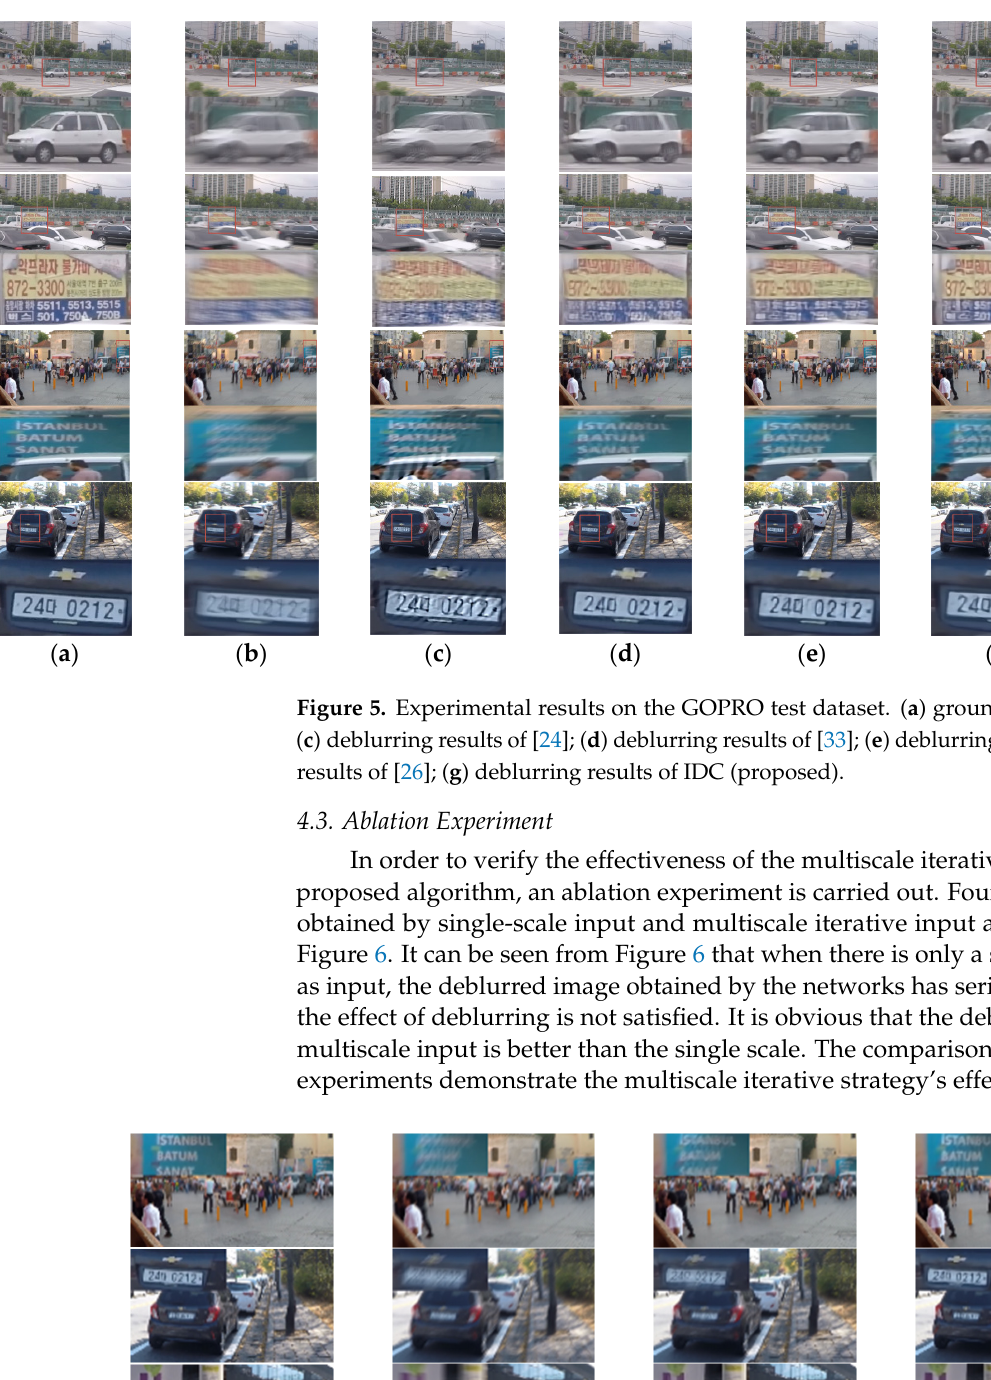
( d ) Figure 7. Ablation Experiment of Texture Sub-Network. ( a ) ground truths; ( b ) blurred images; ( c ) deblurring results of IDC without Sub-Texture; ( d ) deblurring results of IDC (proposed). 5. Conclusions This paper presents an iterative dual-CNN procedure for image deblurring. The net- work consists of deblurring sub-networks, detail recovery sub-networks, and an infor- mation fusion module. Different from the previous approaches, we focus on the inde- pendence and complementarity between images semantic content and detail textures. In addition to the regular deblur branch based on U-net architecture, it is worth noting that we develop a textures extraction branch to ensure extracting complete detail textures fea- tures. The iterative dual CNNs can compensate for the inevitable information loss in tra- ditional U-net architecture. Using the U-Net structure, the deblurring sub-network in-